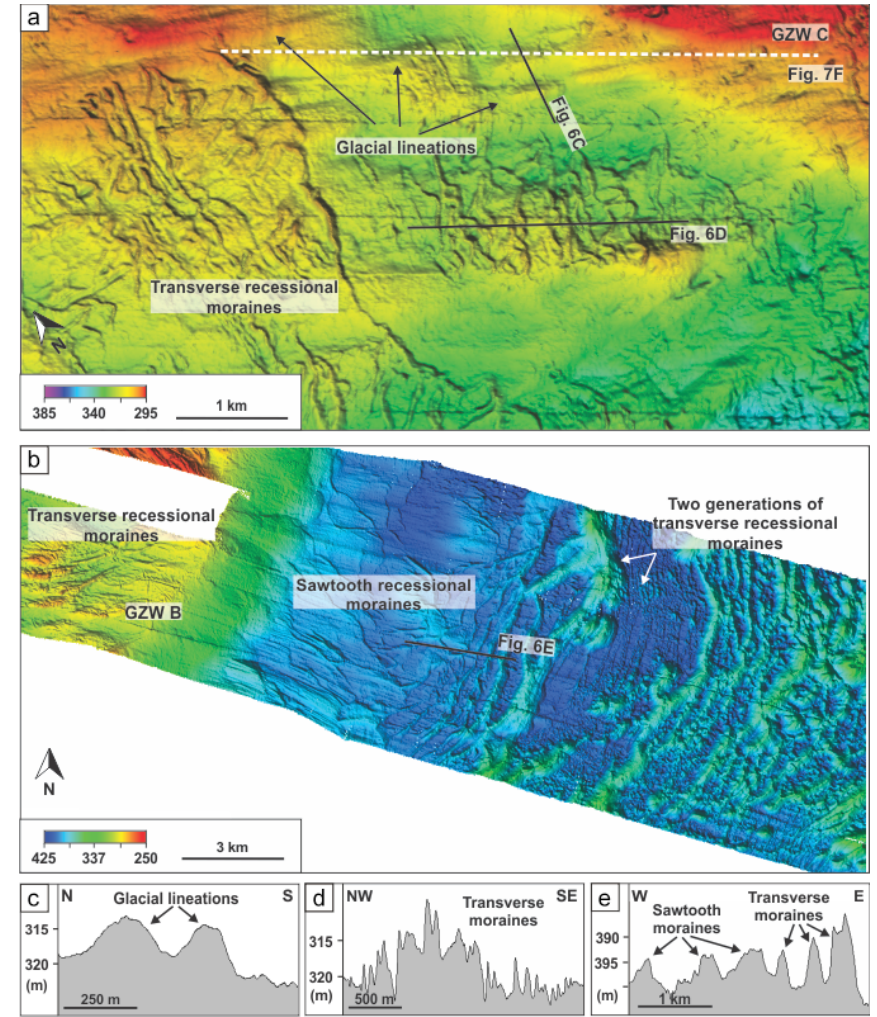
Figure 6. (a) Examples of glacial lineations and transverse recessional moraines. (b) Examples of sawtooth and transverse recessional moraines. (c) Bathymetric cross profile of glacial lineations. (d) Bathymetric cross profile of transverse moraines. (e) Bathymetric profile of sawtooth moraines and transverse